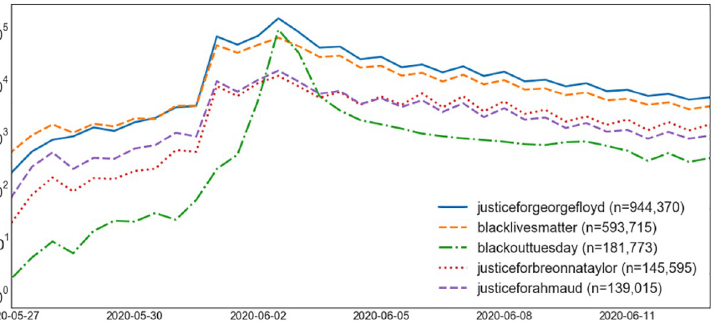
Fig 1. Volume of Instagram posts plotted on an hourly basis, separated by top hashtags shared during the George Floyd protests.